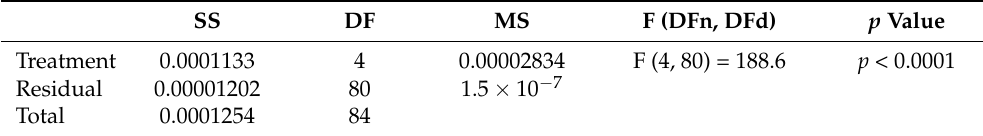
Table 6. Analysis-of-variance (ANOVA) test results.